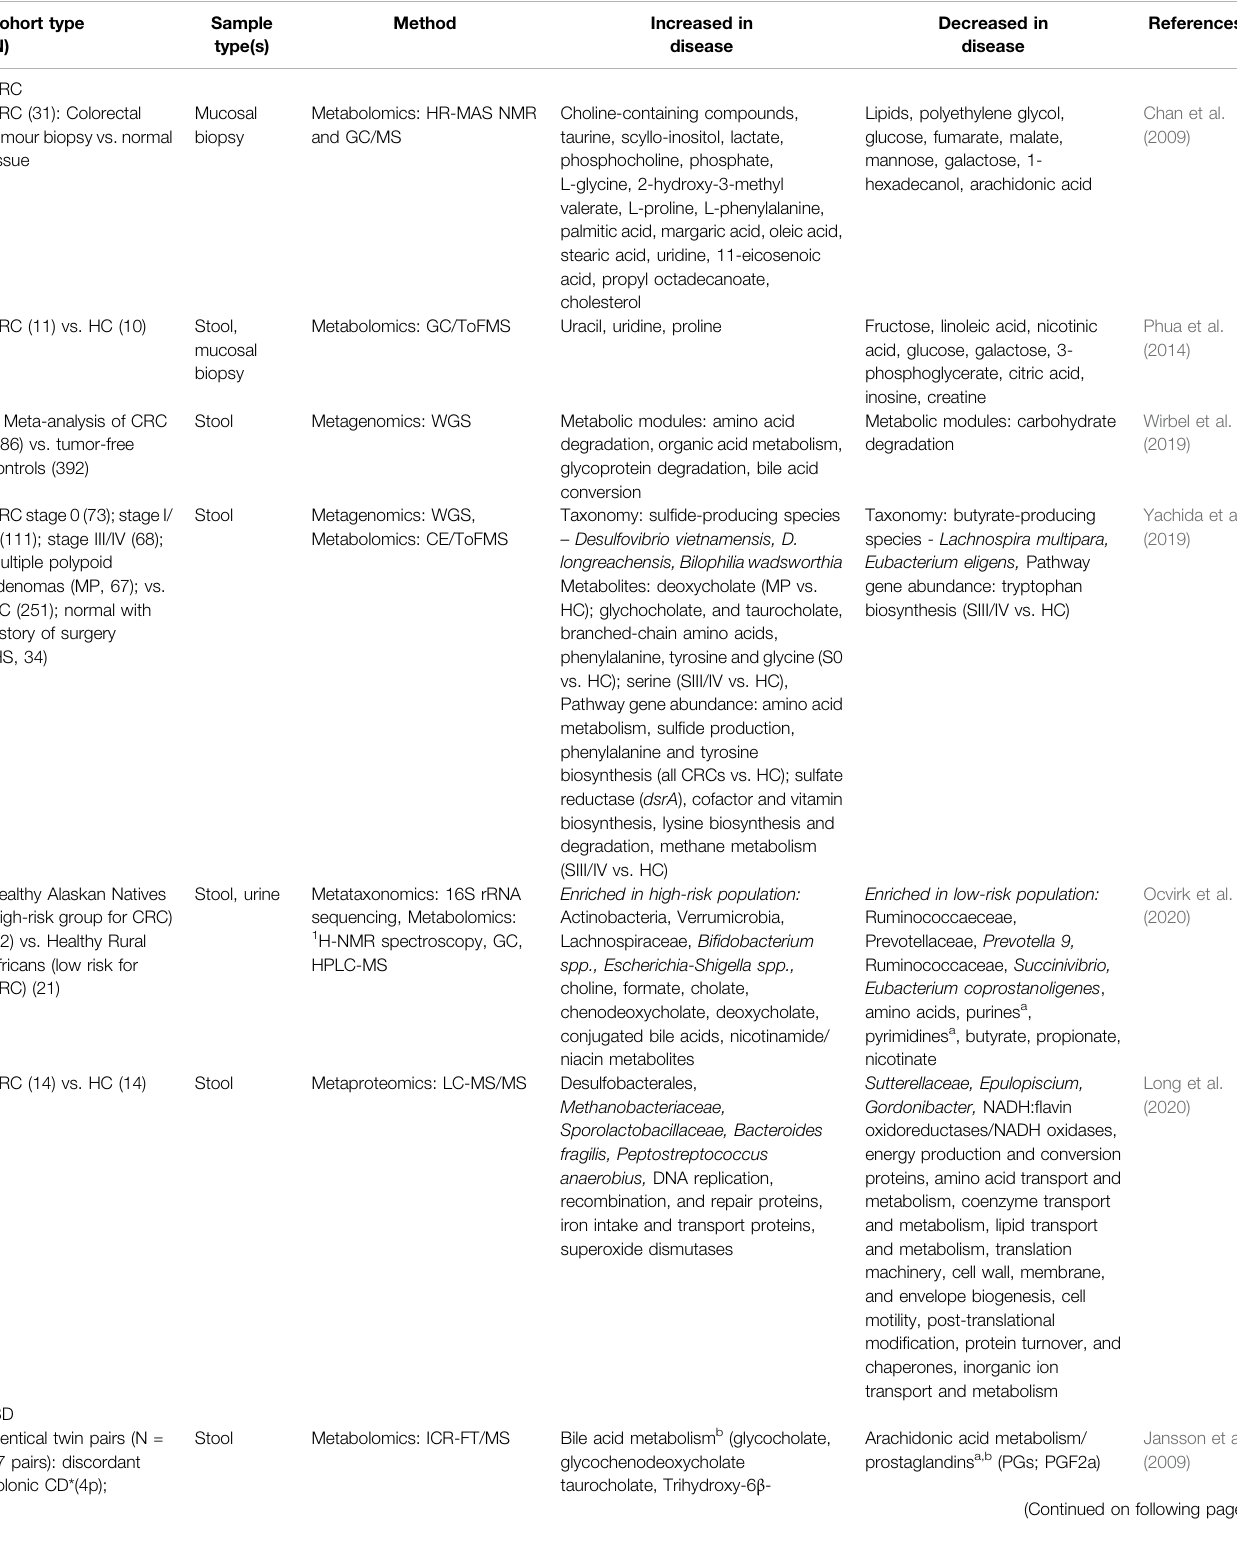
TABLE 1 | Meta-omic studies reporting statistically signi fi cant changes in the GI microbiome in CRC or IBD. Abbreviations: healthy controls (HC); irritable bowel syndrome (IBS); high-resolution magic angle spinning nuclear magnetic resonance (HR-MAS NMR); gas chromatography (GC); capillary electrophoresis (CE); ion cyclotron resonance Fourier transform mass spectrometry (ICR-FT/MS); time-of- fl ight mass spectrometry (ToFMS); liquid chromatography (LC); high performance LC (HPLC); ultra- performance LC (UPLC); medium-chain fatty acids (MCFA); long-chain fatty acids